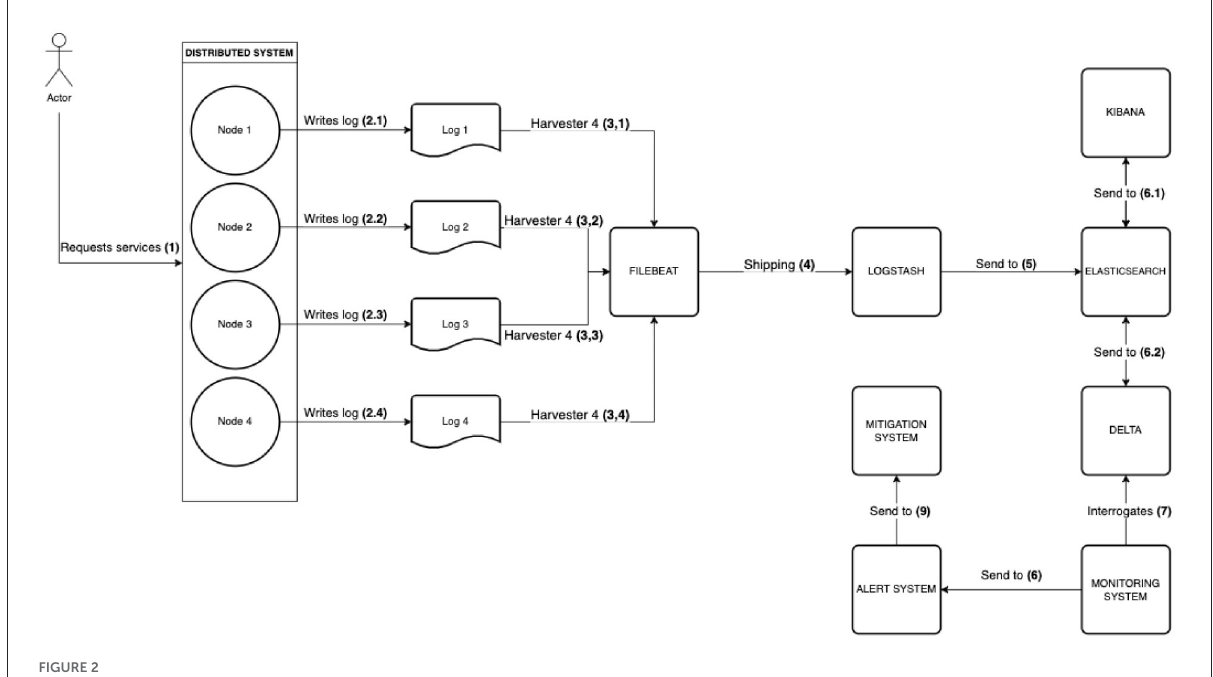
FIGURE2 Data flow